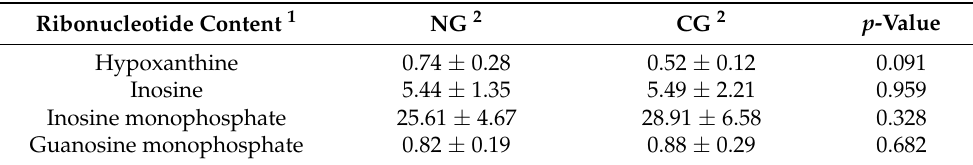
Table 6. The ribonucleotides content in Longissimus thoracis m. of Southern Thai native goats (NG) and Three-way crossbred goats